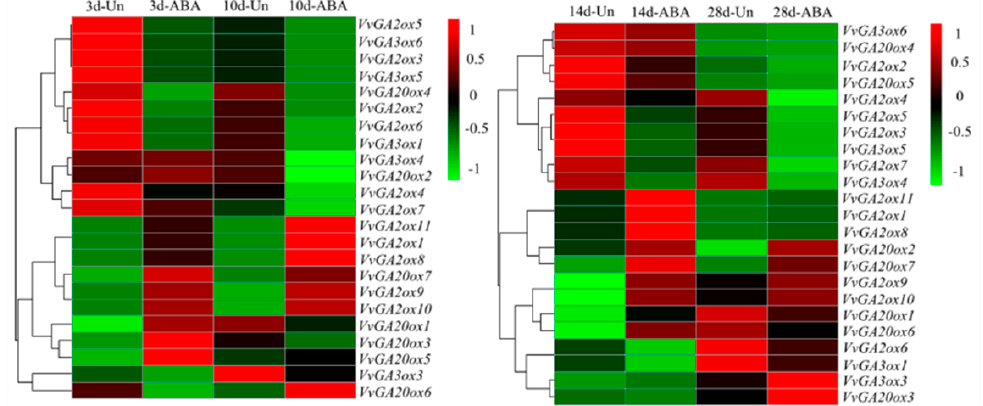
Figure 4. Hierarchical clustering of the expression profiles of 23 VvGAox genes subjected to ABA treatments for 3, 10, 14, and 28 days in grape. In the graph, 3d-Un represent untreated the grape fruit just as control, 3d-ABA represent have been treated grape fruit with ABA, Simultaneously, 10d-Un, 14d-Un, 28d-Un, representing untreated grape fruit at 10, 14, and 28 days, otherwise, 10d-ABA, 14d-ABA, 28d-ABA, representing have been treated the grape fruit at 10, 14, and 28 days. Red or green shading represented the upregulated or downregulated expression level, respectively. The scale denoted the relative expression level.